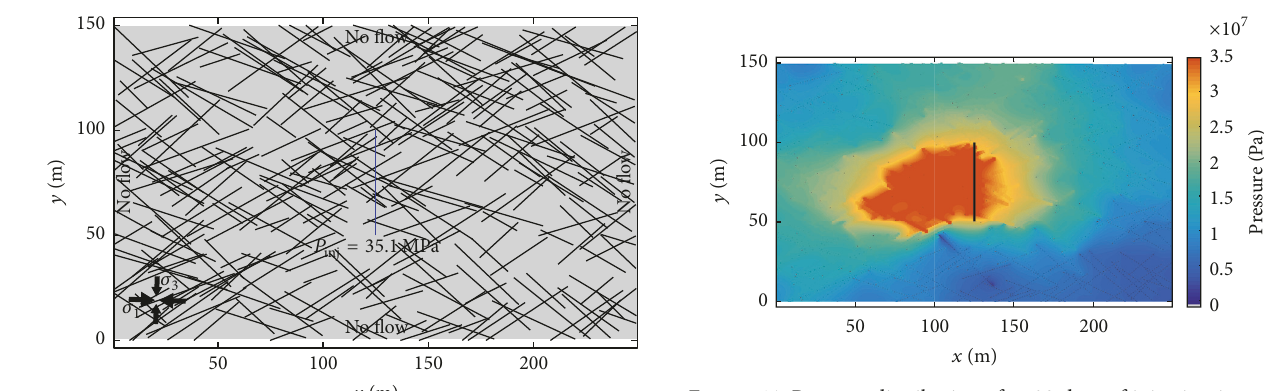
Figure 14: Pressure distribution after 30 days of injection into the fracture network. The heterogeneous fracture distribution influ- ences the pressure field and leads to preferential flow directions in the reservoir. Fracture permeability 𝑘 fr = 10 −11 m 2 . Matrix permeability 𝑘 𝑚 = 10 −18 m 2